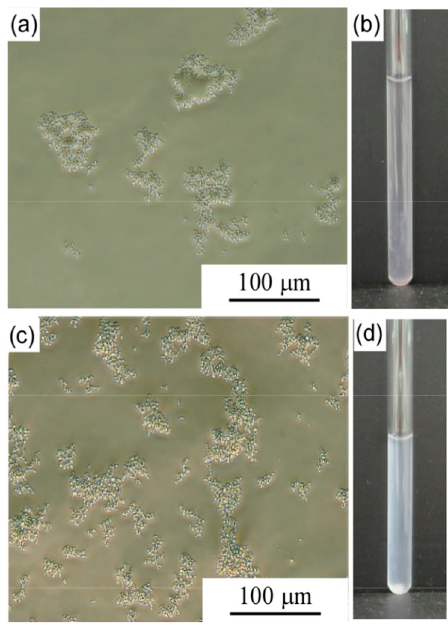
Figure 5. Phase contrast optical microscopic images for ( a ) a 0.1 M NaCl P(VBTAC/NaSS) 20 solution and ( c ) a 1.0 M NaCl P(VBTAC/NaSS) 97 solution at C p = 2.0 g/L and 20 °C, and digital photography images of the same ( b ) P(VBTAC/NaSS) 20 and ( d ) P(VBTAC/NaSS) 97 solutions.